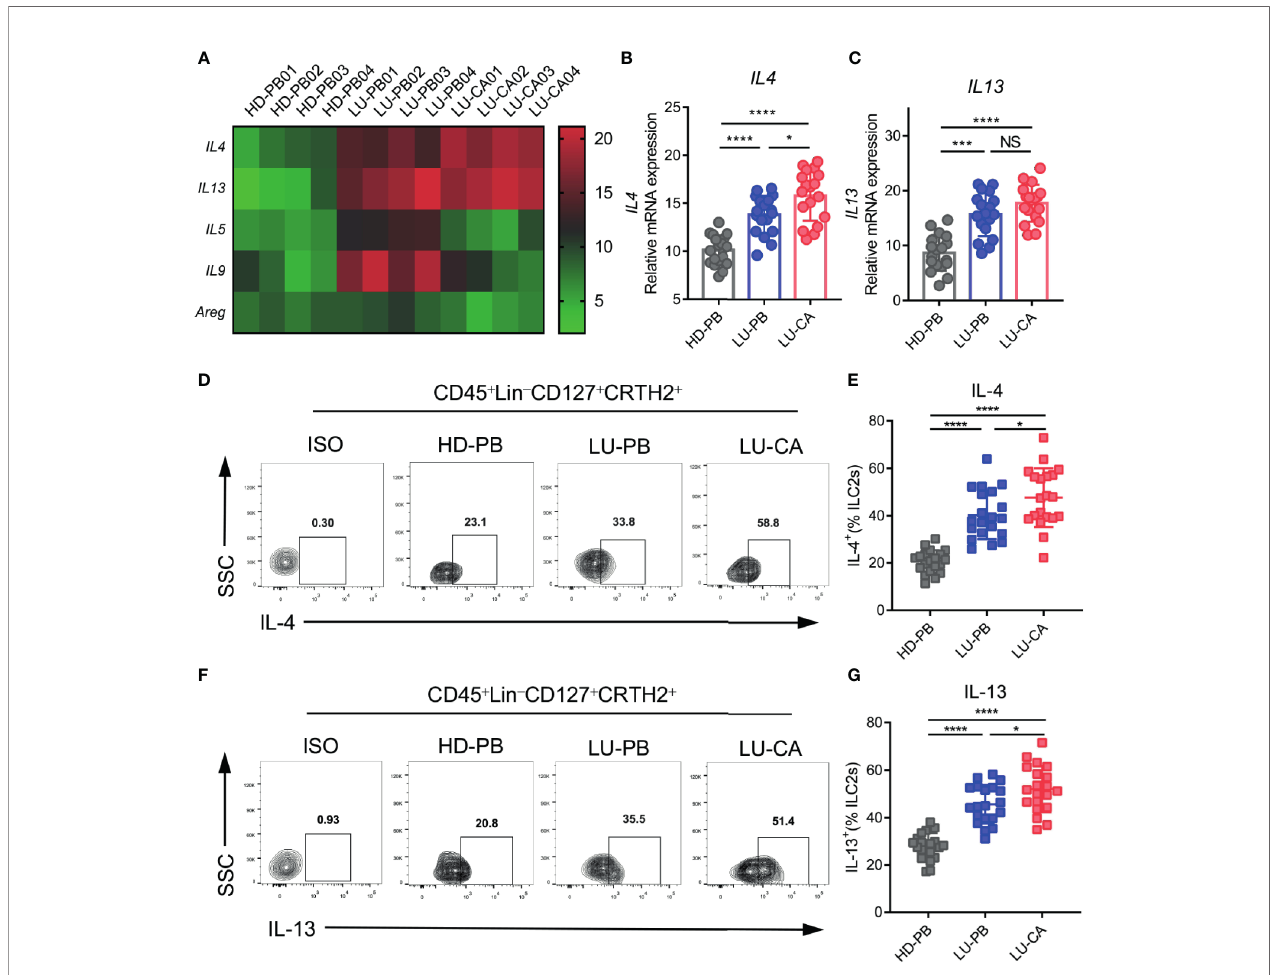
FIGURE 2 | mRNA and protein expression of key functional molecules of ILC2s. (A – C) ILC2s were marked as CD45 + Lin - CD127 + CRTH2 + and sorted via FACS. (A) A heatmap showing representative results of mRNA expression of the key functional molecules of ILC2s obtained from HD-PB, LU-PB, and LU-CA samples. (B, C) The relative mRNA expressions of IL4 (B) and IL13 (C) in ILC2s from HD-PB, LU-PB, and LU-CA samples (for each group, n=18). (D – G) Protein expression of IL-4 (D, E) and IL-13 (F, G) in ILC2s from HD-PB, LU-PB, and LU-CA samples assessed via fl ow cytometry (for each group, n=20). HD-PB: PBMCs from healthy donors, LU-PB: PBMCs from NSCLC patients, and LU-CA: tumor single cell suspension from NSCLC patients. NS, not signi fi cant; * P <0.05, *** P <0.001, **** P <0.0001. P values were calculated by one-way ANOVA and post hoc comparisons were performed via Tukey ’ s